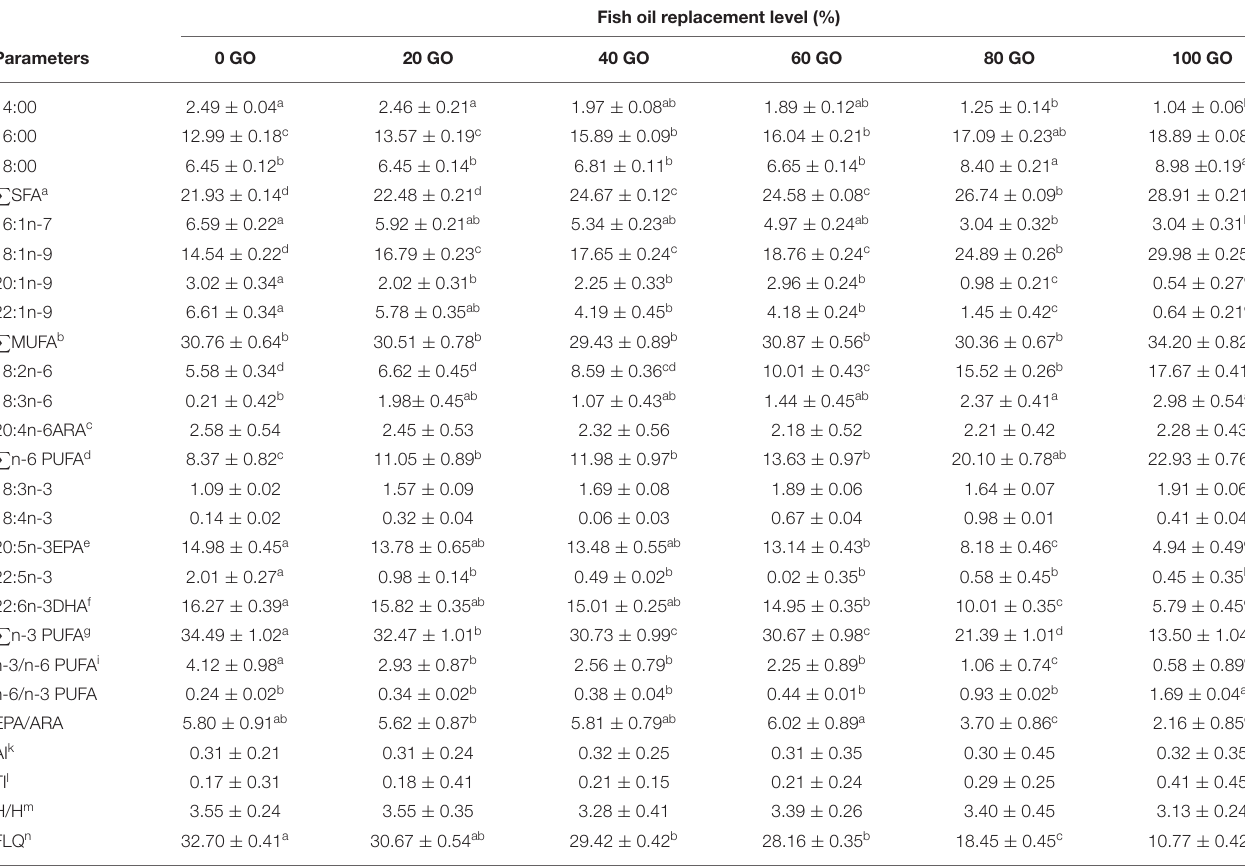
TABLE 6 | Muscle fatty acid compositions of fingerling Labeo rohita fed different experimental diets (% total fatty acids) * , ** .